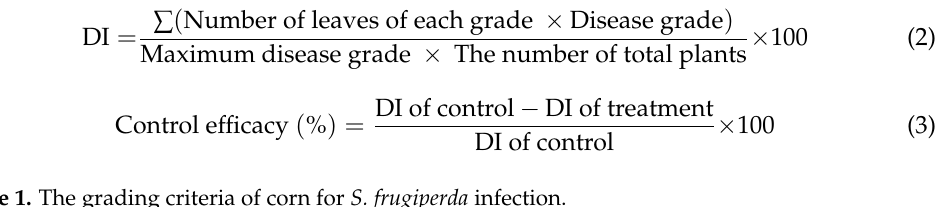
Table 1. The grading criteria of corn for S. frugiperda